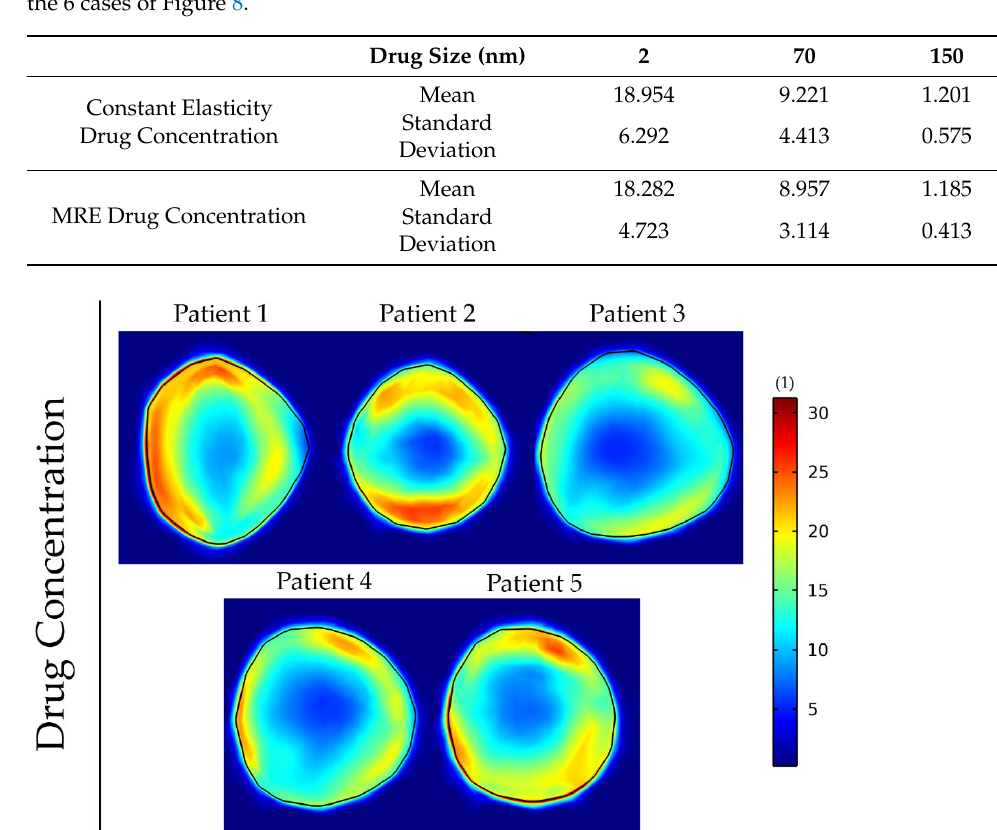
Figure 9. Drug concentration taken up by cancer cells at day 43 of the simulation for anisotropic tumor growth (A = 25). All results are displayed at day 43 of the simulations following a drug administration at day 41. The size of the drug is 2 nm, and the vessel wall pore size was set to 200 nm.